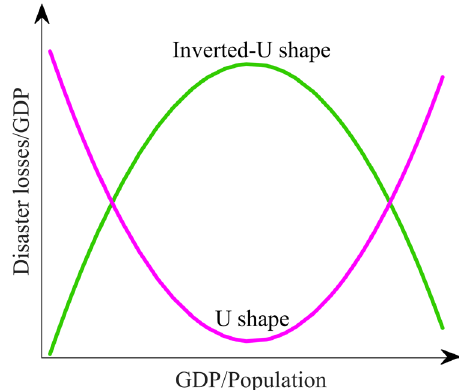
Fig. 1 Conceptual graph of nonlinear relationship between GDP/ population and disaster losses/GDP. Green line represents inverted U-shape relationship, and pink line represents U-shape relationship between GDP/population and disaster losses/GDP.